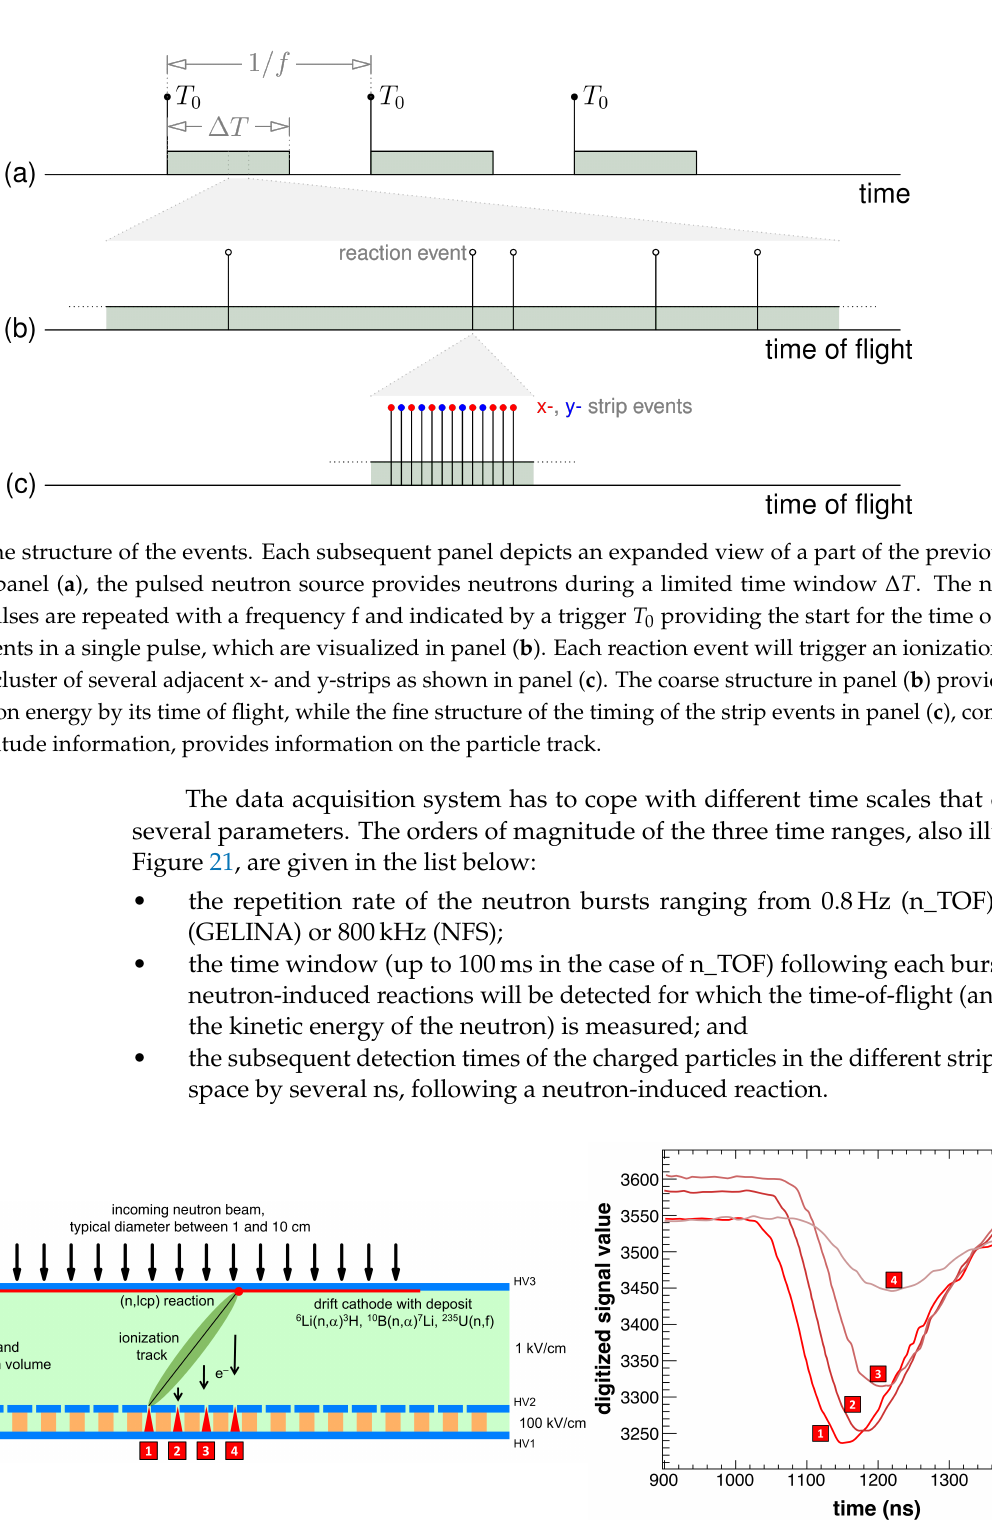
Figure 22. The principle of the low-mass Microbulk Micromegas detector as a neutron detector shown in the left panel. The neutron beam has a typical diameter of several cm. The drift electrode is coated with a thin layer of material creating charged particles by neutron-induced reactions. The ionization track of the resulting charged particle is read out at the mesh/anode. In the right panel, the strip signals from a single neutron interaction as measured in Ref. [100] are